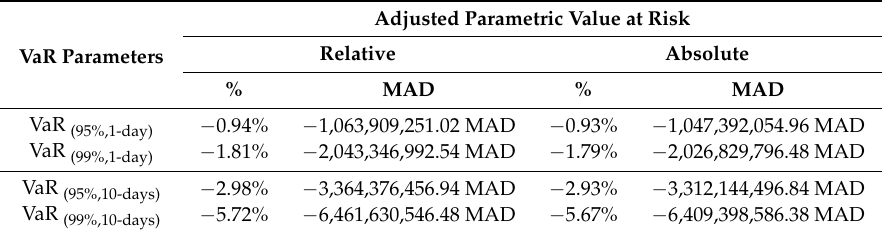
Table produced on Excel under VBA by the authors.